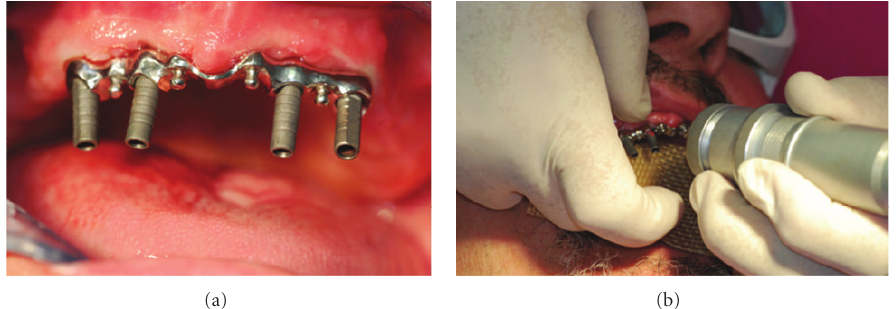
Figure 2: (a) Bar inserted in the abutments. (b) Intraoral laser welding.